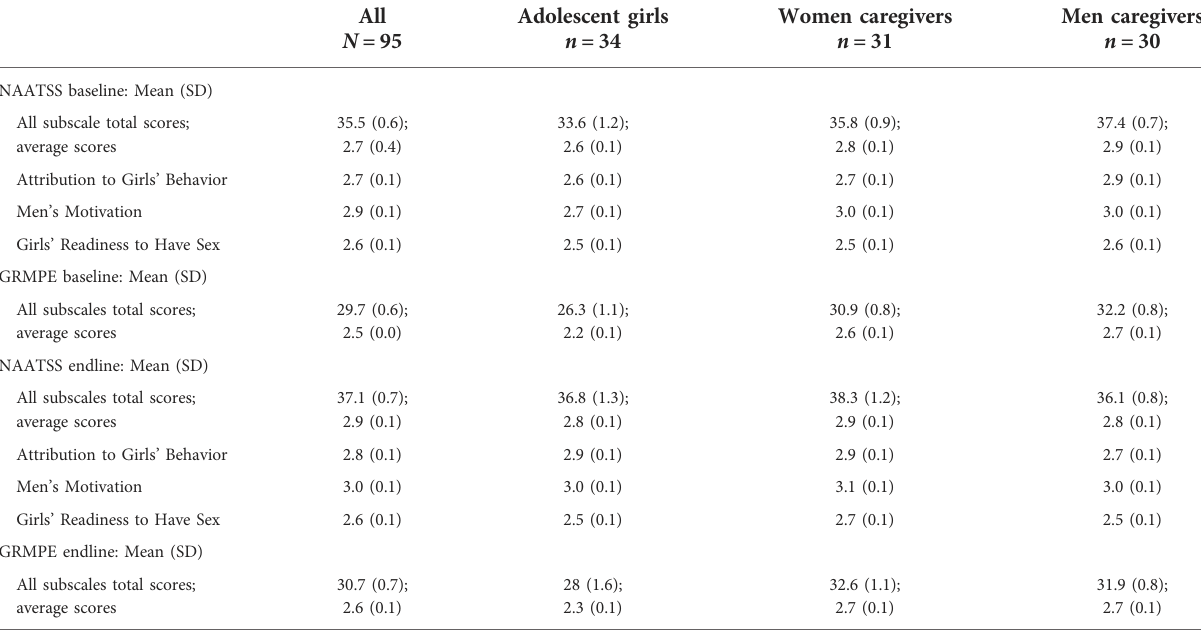
TABLE 3 Baseline and endline scores on the Norms and Attitudes of Age Disparate Transactional Sex scale (NAATSS) and the Gender Roles and Male Provision Expectations (GRMPE) scale among adolescent girls, women caregivers and men caregivers.